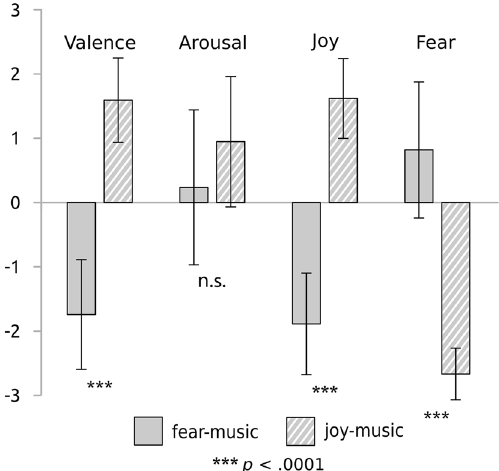
Figure 1. Behavioral ratings. Boxes with error bars (means and standard deviations) indicate the behavioral ratings on the four felt emotion scales: valence (“How pleasant have you felt?”), arousal (“How excited have you felt?”), joy (“How joyful have you felt?”), and fear (“How fearful have you felt?”). Scales ranged from -3 (“not at all”) to 3 (“very much”). Results are shown separately for each stimulus category: ratings for fear-music are indicated by plain grey boxes, and ratings for joy-music by hatched boxes. Joy stimuli evoked markedly stronger feelings of pleasure and joy (compared with fear stimuli), while fear stimuli evoked a stronger feeling of fear (compared with joy stimuli). Arousal did not differ significantly between joy- and